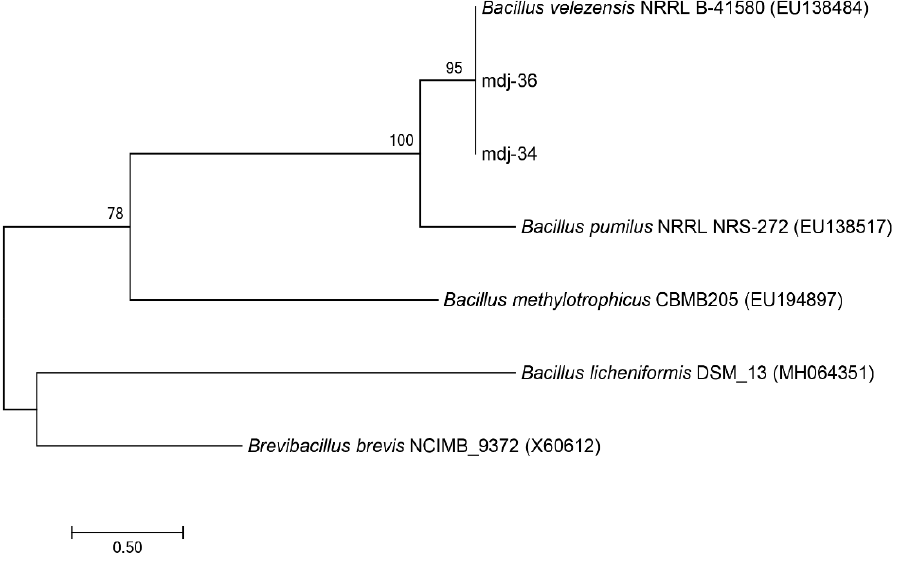
Figure 1. The phylogenetic tree based on DNA sequences encoding 16S rRNA gene for the two selected strains. Bootstrap values (%) presented at the branches were calculated from 1000 replications.